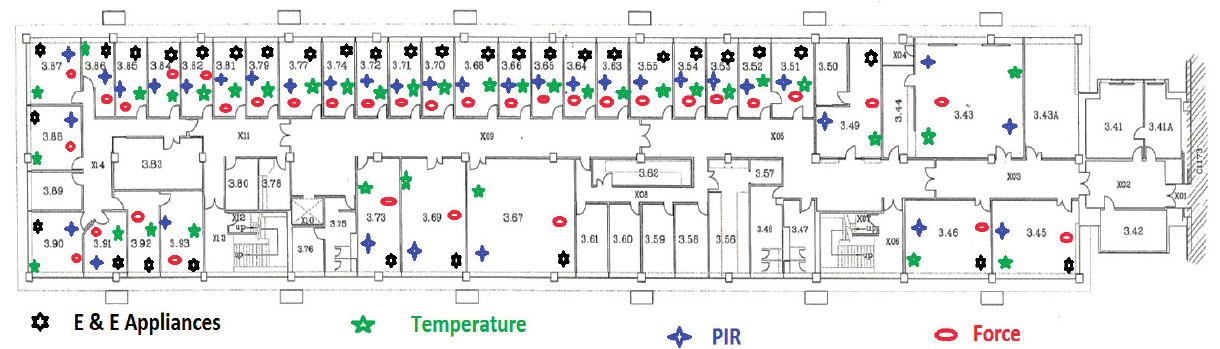
Figure 12. Building layout representing sensors’ placement.